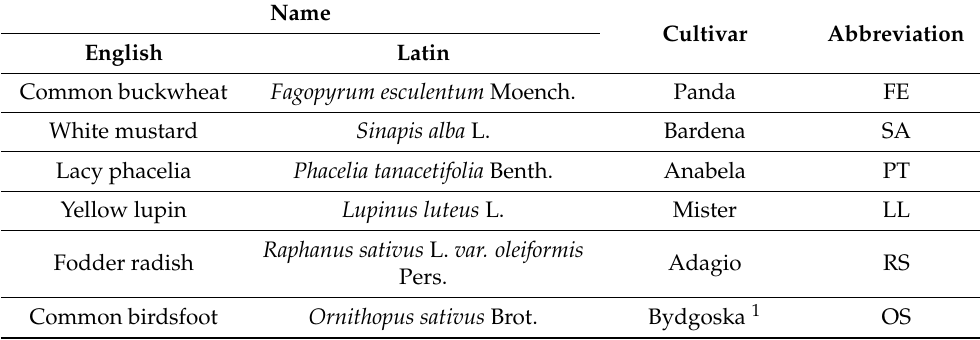
Table 2. Crop species and cultivars used to prepare the seed meals [17]. Name